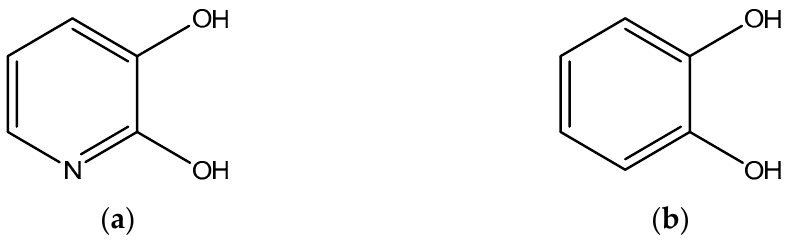
Figure 2. Chemical structure of iron sensitive dyes: ( a ) DHP and ( b ) DHB.